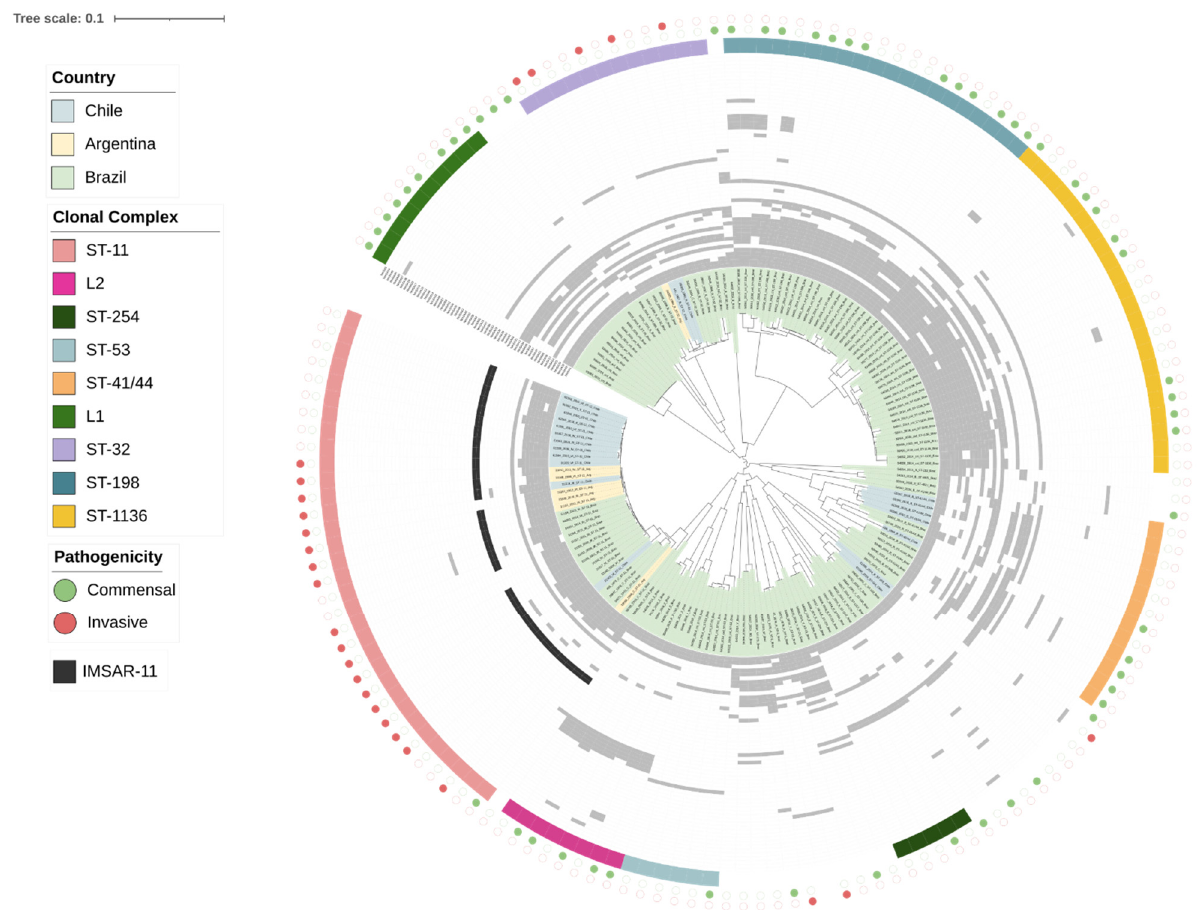
Figure 1. Prophage presence in N. meningitidis genomes from South America. The phylogenetic tree was constructed from 157 nucleotide genome sequences using the Harvest suite tool [18] and RAxML-NG [19]. Metadata were added on the phylogenic tree (from innermost to outermost: country, presence of the 56 prophage species—depicted in grey—, clonal complex, and pathogenicity). IMSAR-11 (Invasive Meningococci from South America Related to cc11) is depicted in dark grey. The grouping of prophages into families was carried out with the D6 formula of VICTOR [20]. A 0.4 LS-BSR score [21] was the threshold of a prophage presence. The order of prophage species from inner to outermost is the same as VICTOR’s output. When the pathogenicity of a genome is not described in the PubMLST database, the circle is not color-filled.